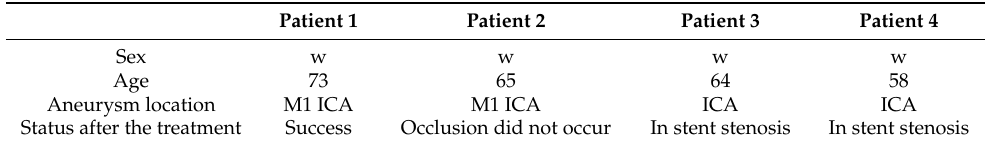
Table 1. Patient sample characteristics and clinical